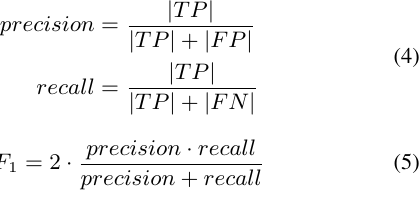
Table 3. Evaluation of using Bildstein dataset. results, these parts also appears zigzag connection influencing fi- nal accuracy.